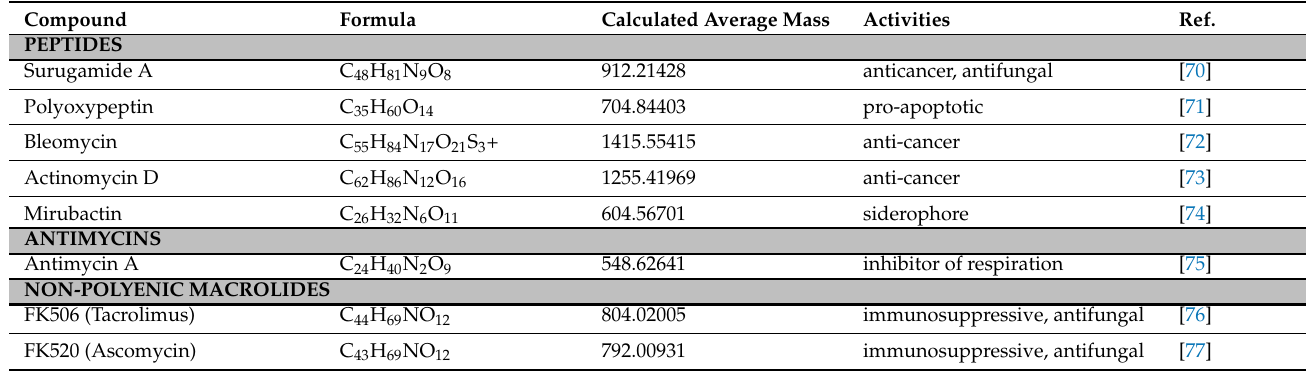
Table 2. Non-polyene SMs of actinomycetes targeting human